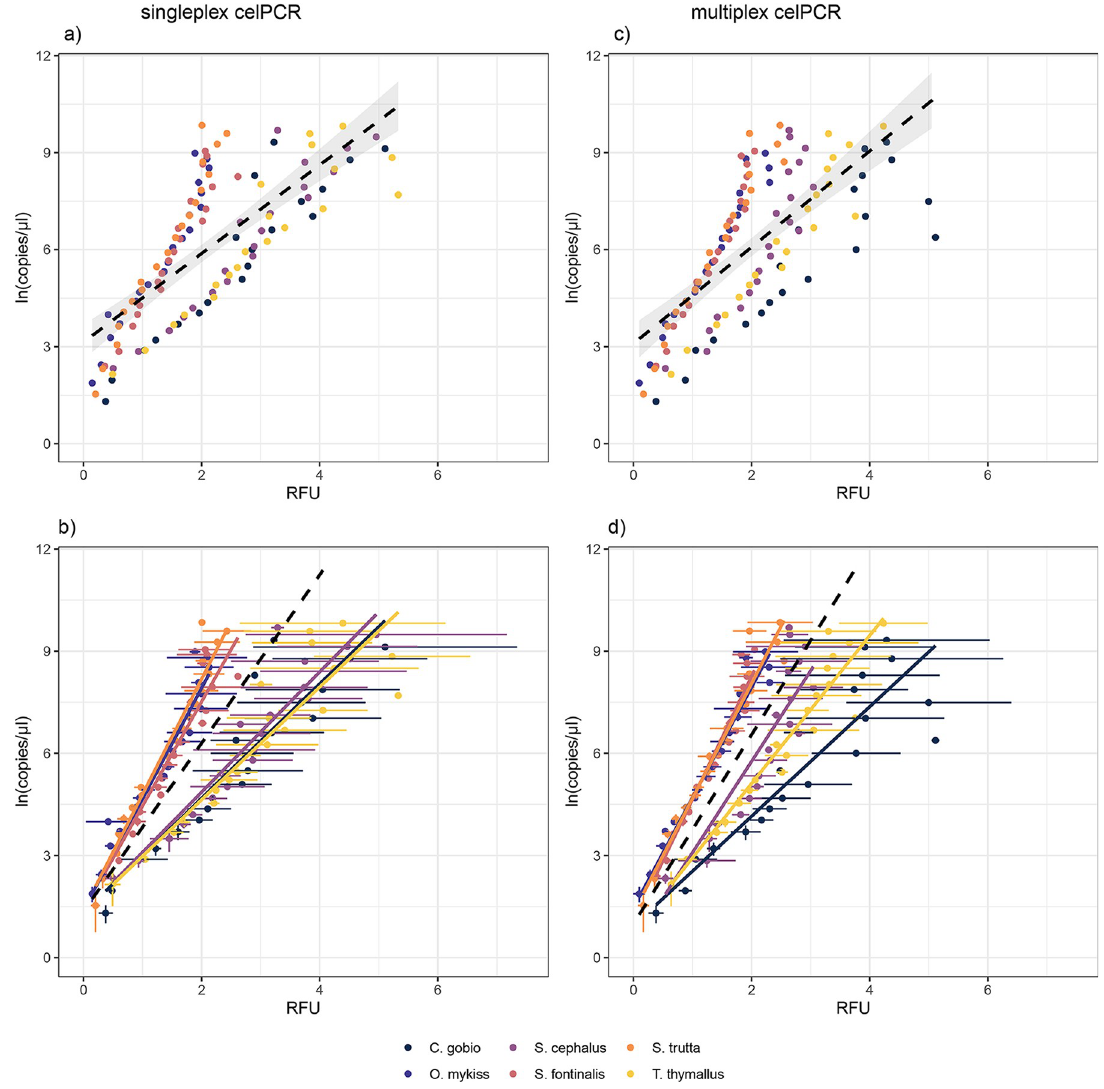
Fig 3. Linear models and linear mixed-effects models (LMM) for singleplex and multiplex celPCR in relation to ln -transformed copy numbers per μ l extract. Panels a) and c) display mean RFU and copy numbers per dilution step. Values are color coded by species, the black dashed line represents a linear model fitted onto this dataset without accounting for target species identity, the shaded area depicts the 95%-CIs; see S3 File for model specifications. Panels b) and d) show the LMM using target species identity as random effect and permitting random slope and intercept (Table 3). Dots represent mean RFU and copy numbers per dilution step, with the corresponding standard deviations displayed as whiskers. The black dashed line depicts the linear model of the population mean; colored lines are the slopes associated with the individual